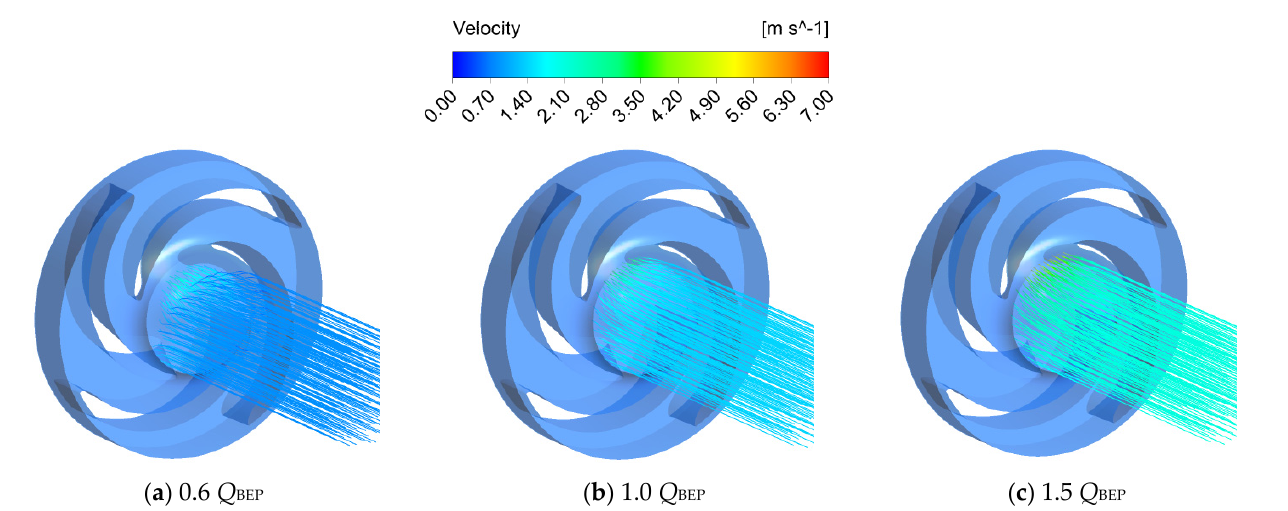
Figure 5. ( a – c ) Flow distribution in the inlet section under two-phase flow.